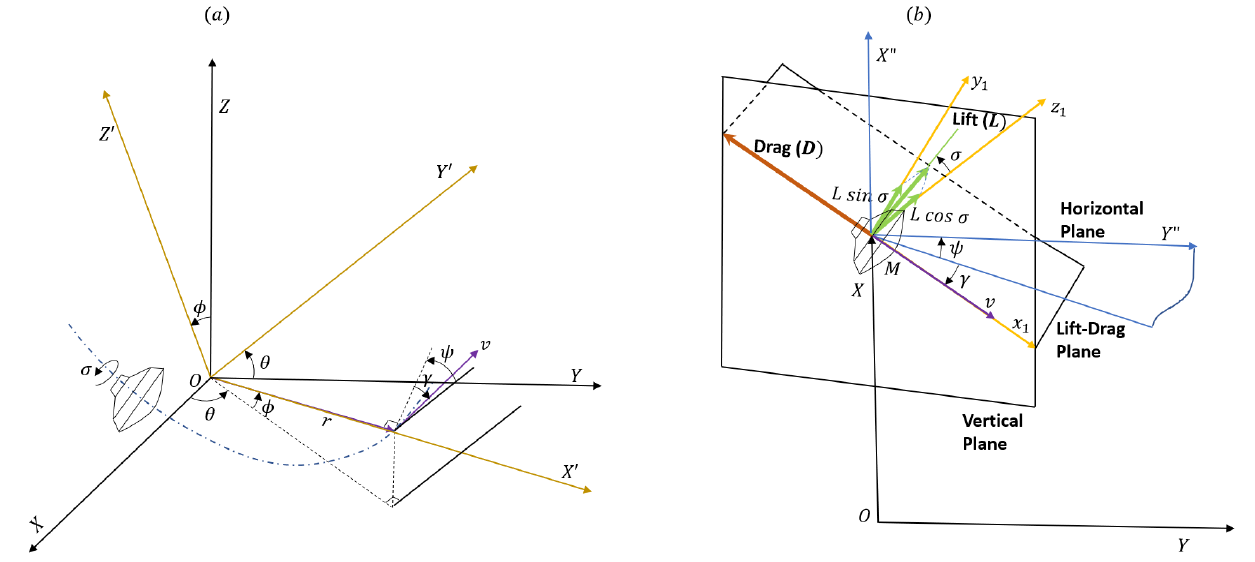
Figure 2. ( a ) Geometry of motion of entry vehicle. ( b ) Aerodynamic forces acting on the entry